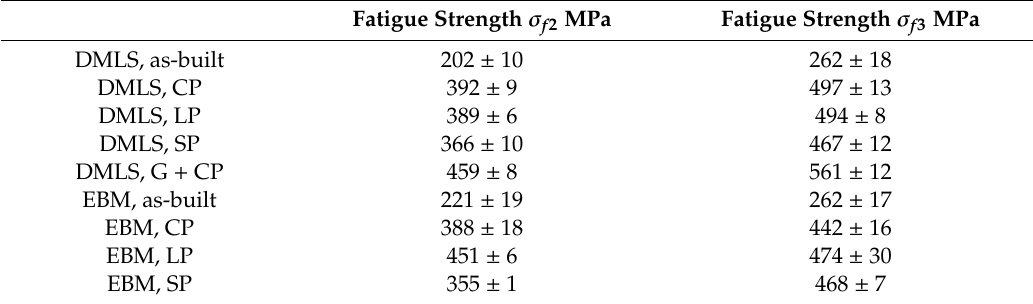
Table 2. Fatigue strength considering the roughness and defect of the as-built Ti6Al4V manufactured by DMLS and EBM and the Ti6Al4V manufactured by DMLS and EBM through cavitation peening (CP), laser peening (LP), shot peeing (SP), grinding (G), and cavitation peening after grinding (G +